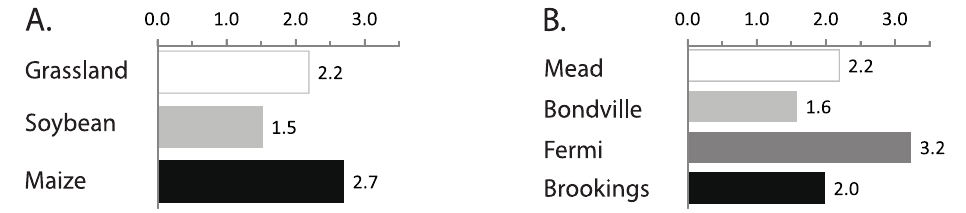
Fig. A1. Root Mean Squared Errors produced by Penman-Monteith model: arranged (A) by vegetation/crop type and (B) by location.